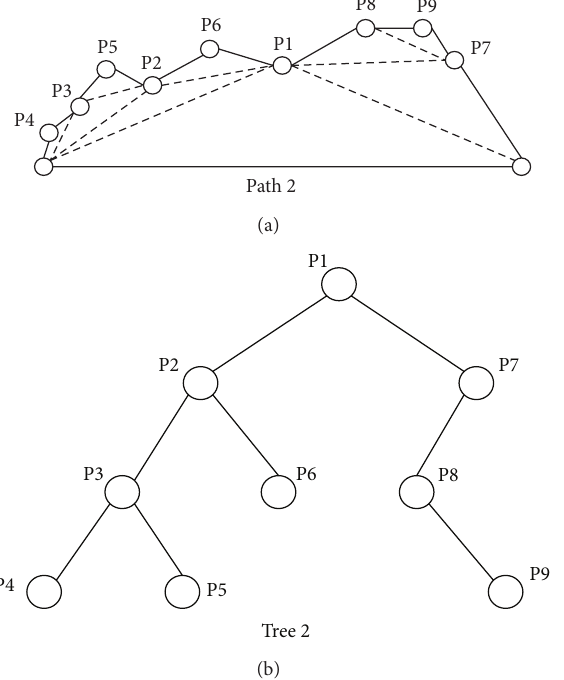
Figure 5: A path with 9 turning points and its corresponding binary tree.